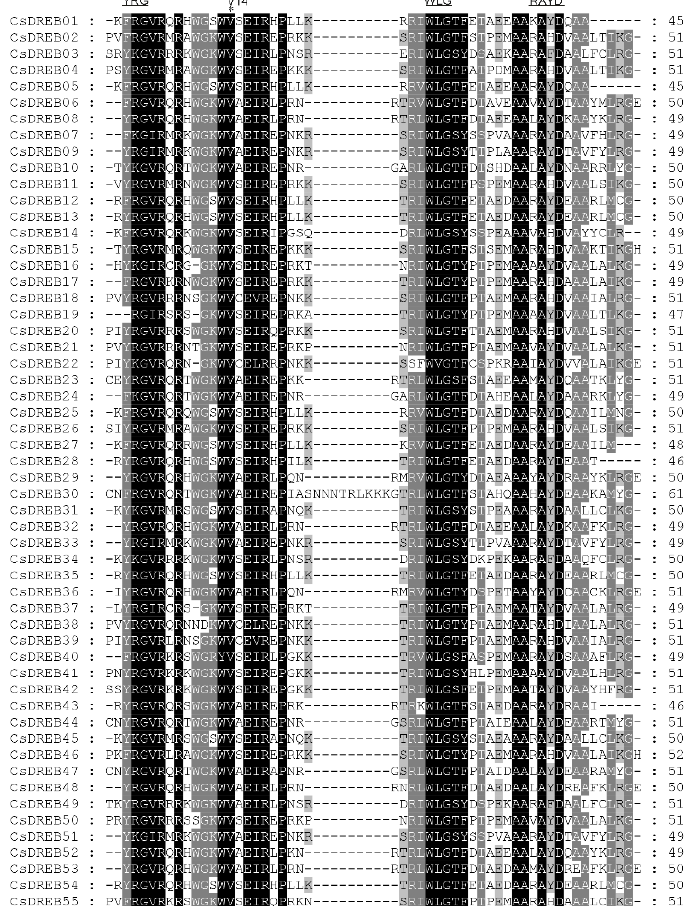
Figure 1. The multiple protein sequence alignment of the AP2 domains of DREBs from cucumber: Conserved V14, YRG, RAYD, and WLG motifs are highlighted by the asterisks and lines. Conserved sequences are highlighted by black and grey shading; the black shading represents completely conserved sequences, while the grey shading represents incompletely conserved sequences.